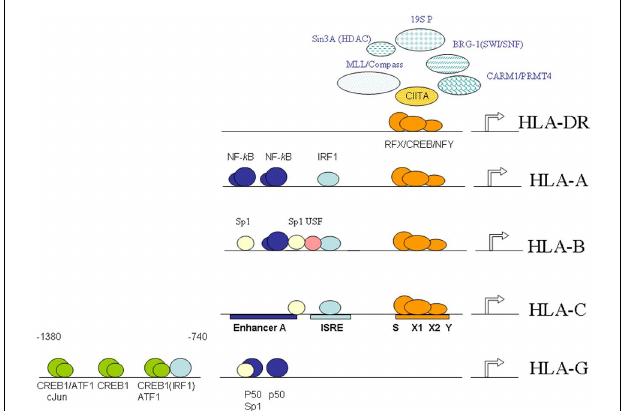
FIGURE 1 | Schematic overview of the elements, interacting factors and epigenetic events governing MHC-I and MHC-II transcription. Shown is the shared proximal SXY-module, and the upstream enhancer A and ISRE typical for MHC-I promoters with the exception of HLA-G.The proximal SXY-module is bound by the